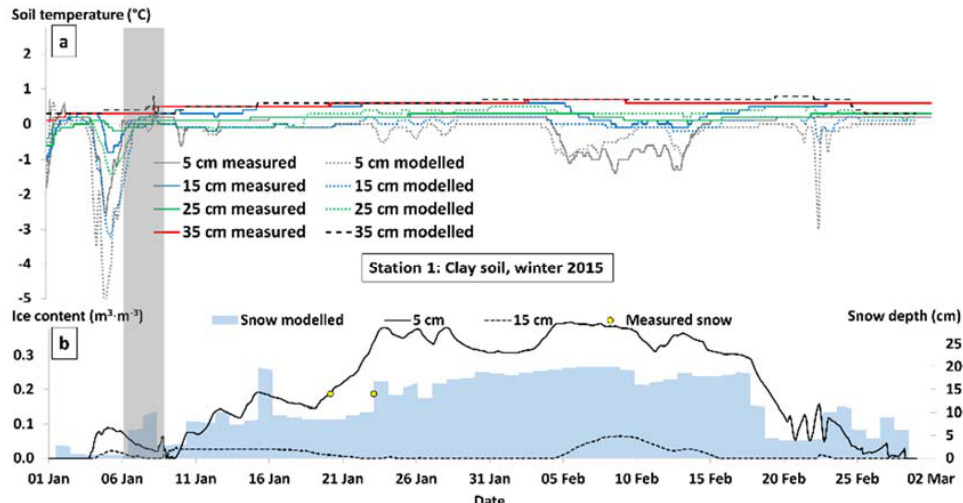
Figure 9. Diagram of ( a ) modelled and measured soil temperature at four depths (5, 15, 25 and 35 cm) in the clay soil (at Station 1) during winter 2015; diagram of ( b ) measured and modelled snow depths at Station 1 and modelled ice content at four depths in the clay soil (was zero at 25 and 35 cm). The duration of the rain event of interest is marked with a grey band.